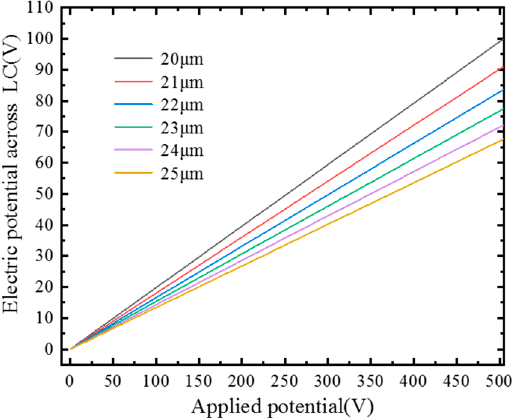
Figure 3. The relationship between the potential difference between the two ends of the liquid crystal with different thicknesses of the fiber and the applied